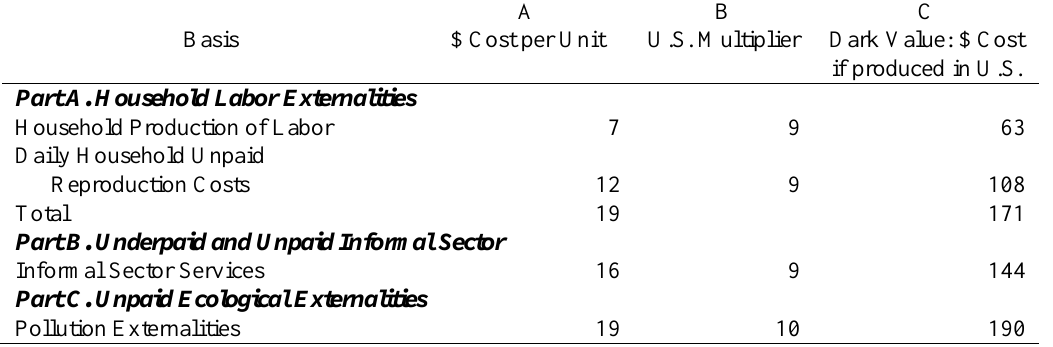
Table 4. Underpaid and Unpaid Externalities in the iPad Supply Chain (China Only) Basis